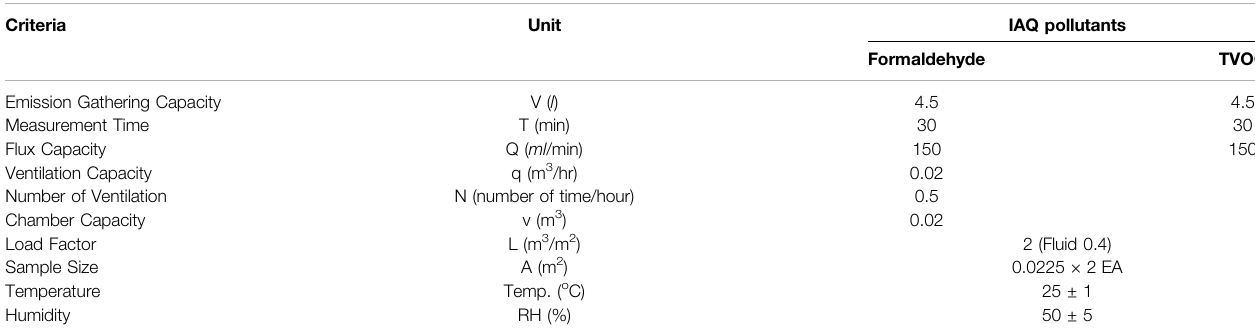
TABLE 8 | Con fi guration of experimental small chamber.